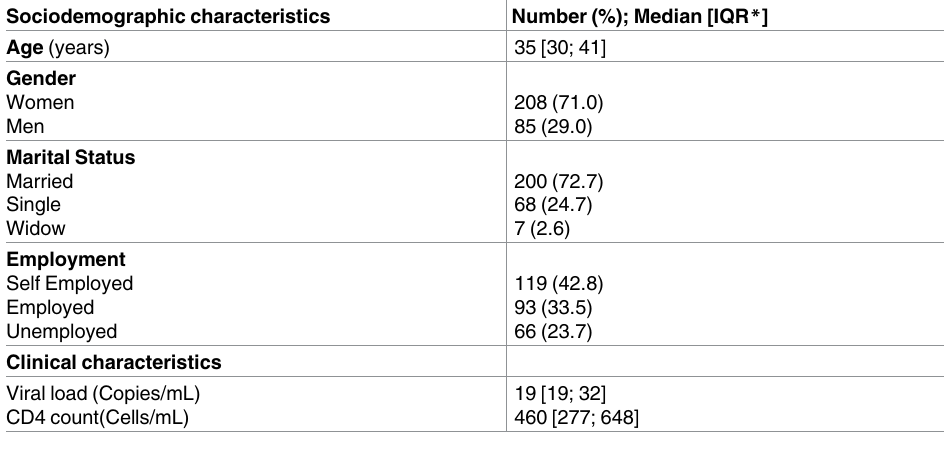
Table 1. Baseline demographic and clinical characteristics of the